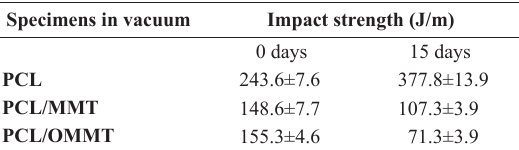
Table 4: Impact strength of PCL and PCL/MMT and PCL/OMMT compounds subjected into vacuum at 40 o C Specimens in